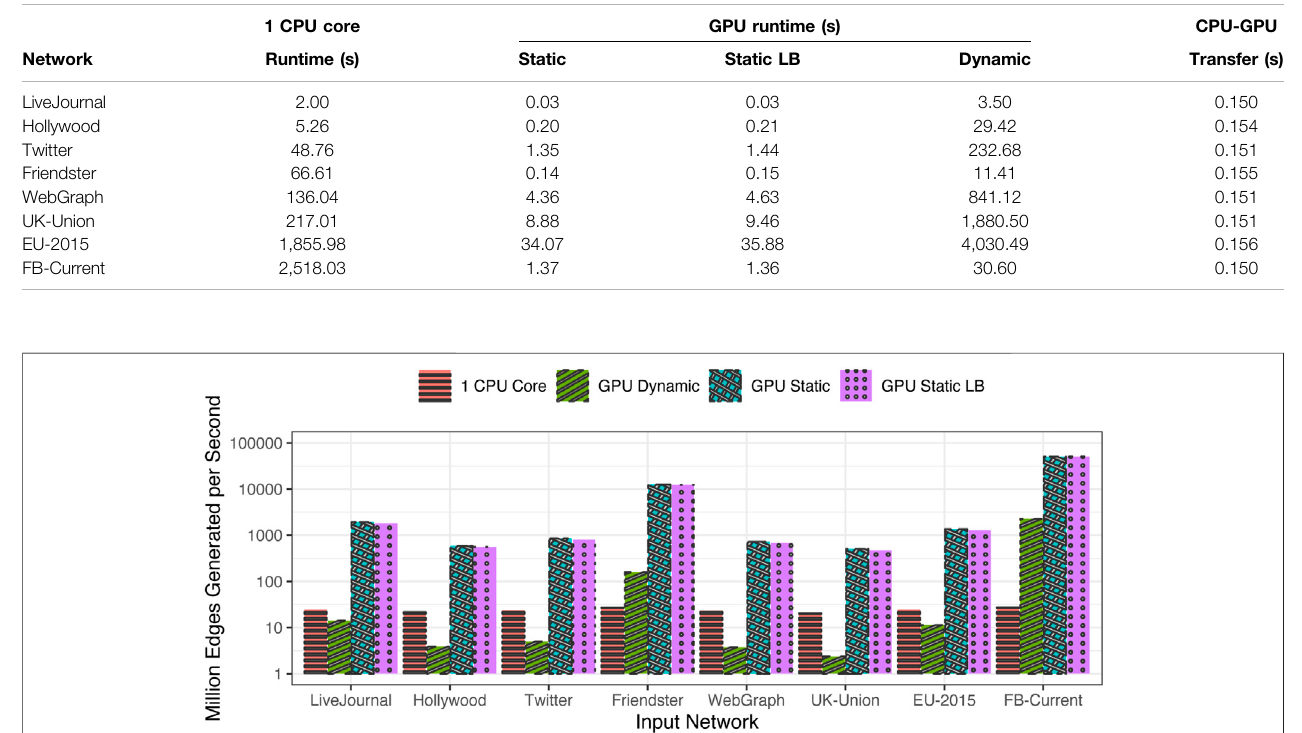
TABLE 2 | Network generation time for original input degree distributions.